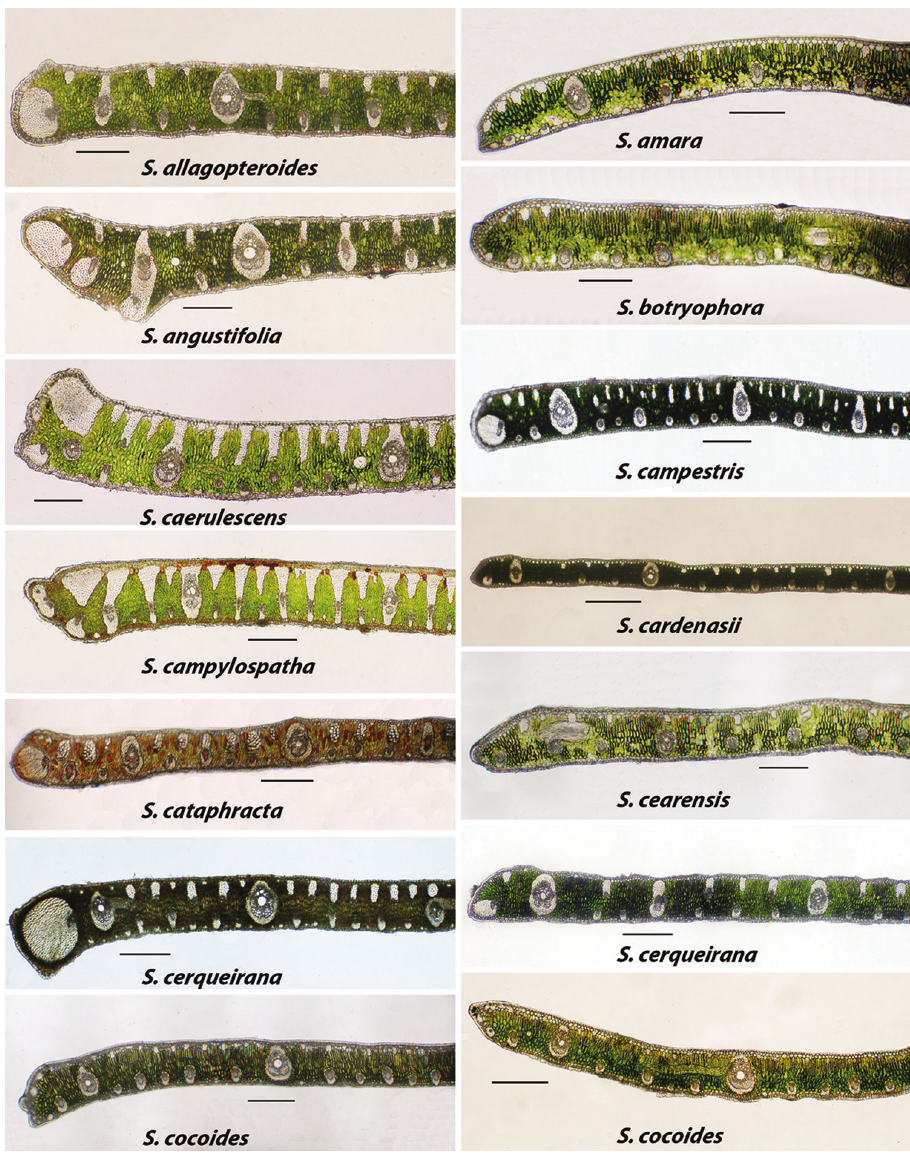
Figure 3. Alphabetically arranged marginal leaflet transections. Syagrus allagopteroides to S. cocoides . Bar scale = 0.25